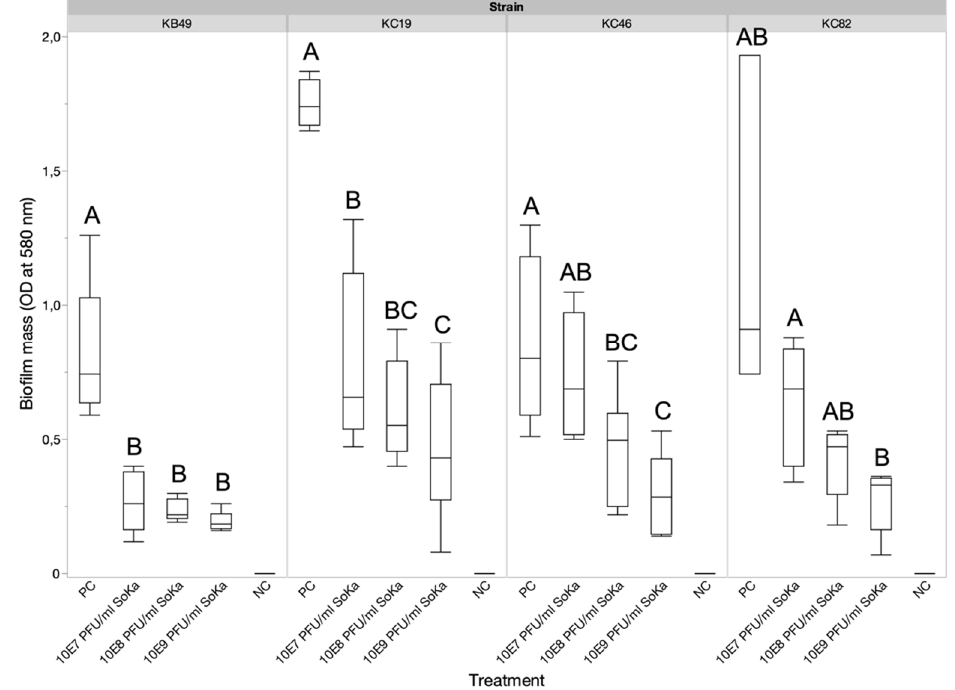
Figure 5. Biofilm mass reductions of different Pss strains by SoKa phage treatment at different concentrations (10 7 , 10 8 , and 10 9 PFU/mL). For each strain, significant differences between the different treatment groups are indicated by a connecting letters report ( p < 0.05). For KB49 and KC82 (unequal variances), a Games–Howell test was used, while for the two other strains (equal variances), a Student’s t -test was run to compare the means of the different treatments to that of the untreated control. PC = positive bacteria-only control; NC = negative LB medium